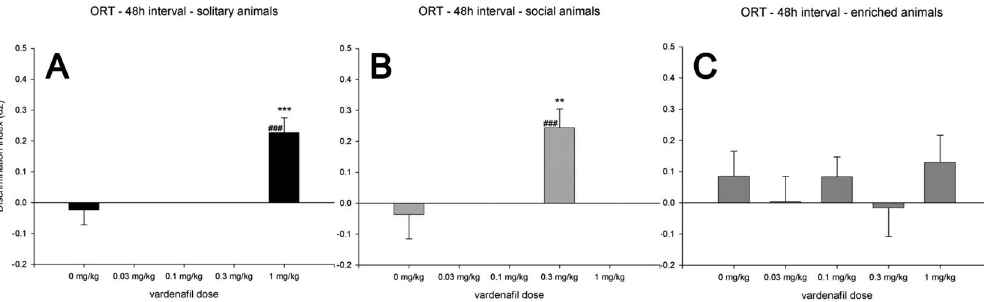
Figure 4. ORT 48 h intervals. Discrimination performance (d2, mean + SEM) of SOL (A), SOC (B) and EE (C) rats after administration of different doses of vardenafil in the object recognition task. All housing conditions were tested in a 48 h retention interval in combination with 0, 0.1, 0.3 and 1 mg/kg vardenafil (x-axis), EE animals also received 0.03 mg/kg vardenafil. A difference from zero is indicated with hash symbols (one-sample t -test; ### : p , 0.001), differences from the vehicle condition (0 mg/kg) within the same retention interval are indicated with asterisks (Tukey HSD; **: p , 0.01; ***: p , 0.001). Of note, the 0 mg/kg vardenafil conditions are identical to those used in Figure 2. Western Blotting Differences between the different housing conditions in dorsal hippocampal protein levels were investigated using Western Blots (Table 2). One-way ANOVA between the housing conditions revealed no differences in the levels of synaptophysin ( F (2,22)= 0.74, n.s.; Figure S4A), PSD95 ( F (2,26) =1.99, n.s.; Figure S4B), proBDNF ( F (2,25) =0.72, n.s.; Figure S5A), mature BDNF ( F (2,24) =1.78, n.s.; Figure S5B), pGSK-3 b ( F (2,22) =0.46, n.s.; Figure S6A) and b -catenin ( F (2,24)= 1.32, n.s.; Figure S6B). On the other hand, there were significant differences in the levels of ERK2 ( F (2,24) = 17.62, p , 0.001; Figure S7A) and pCREB ( F (2,26)= 3.79, p , 0.05; Figure S7B). Post-hoc analysis showed